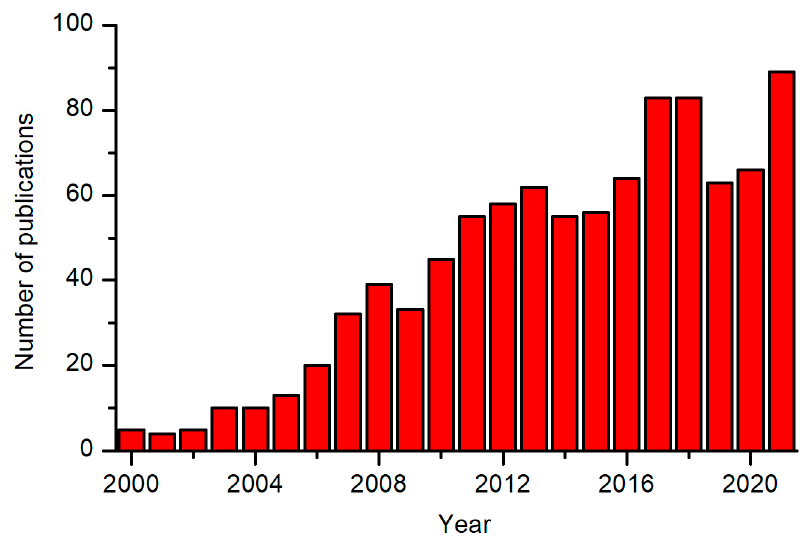
Figure 1. The number of publications published each year on plasma modification of textiles. The data were obtained from the Web of Science by searching with the keywords “textile” and “plasma” and “surface”.